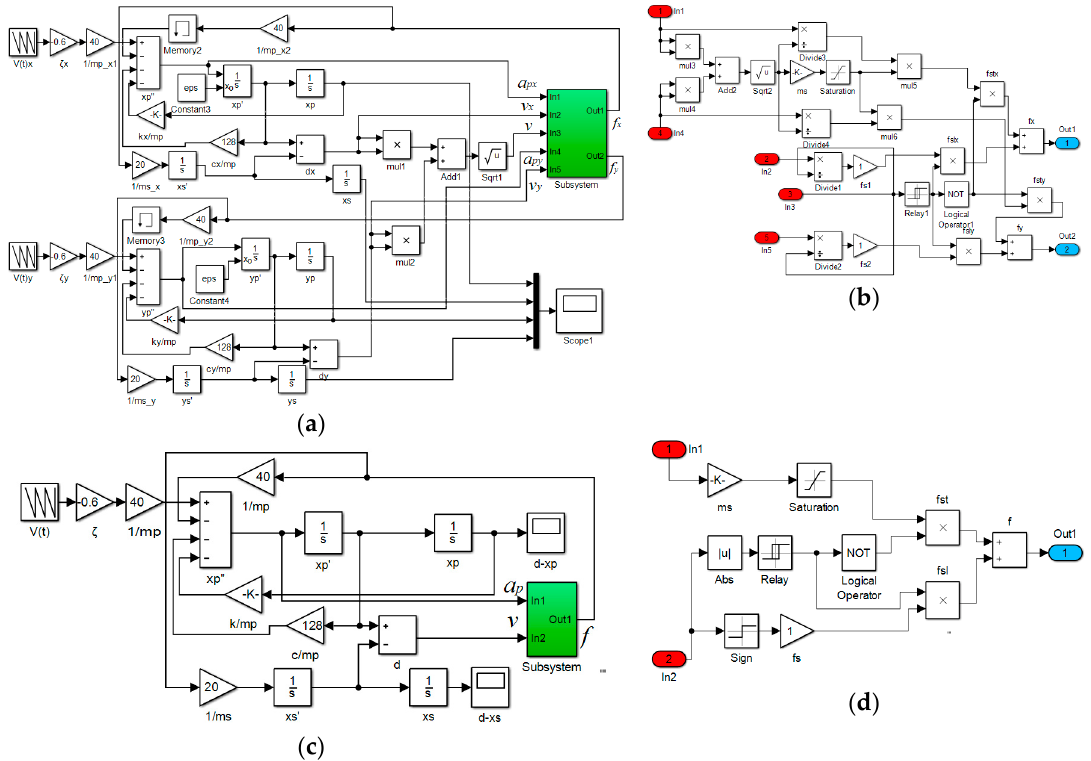
Figure 4. Simulation block: ( a ) 2-DOF whole block diagram; ( b ) 2-DOF subsystem block diagram; ( c ) 1-DOF whole block diagram; ( d ) 1-DOF subsystem block diagram.